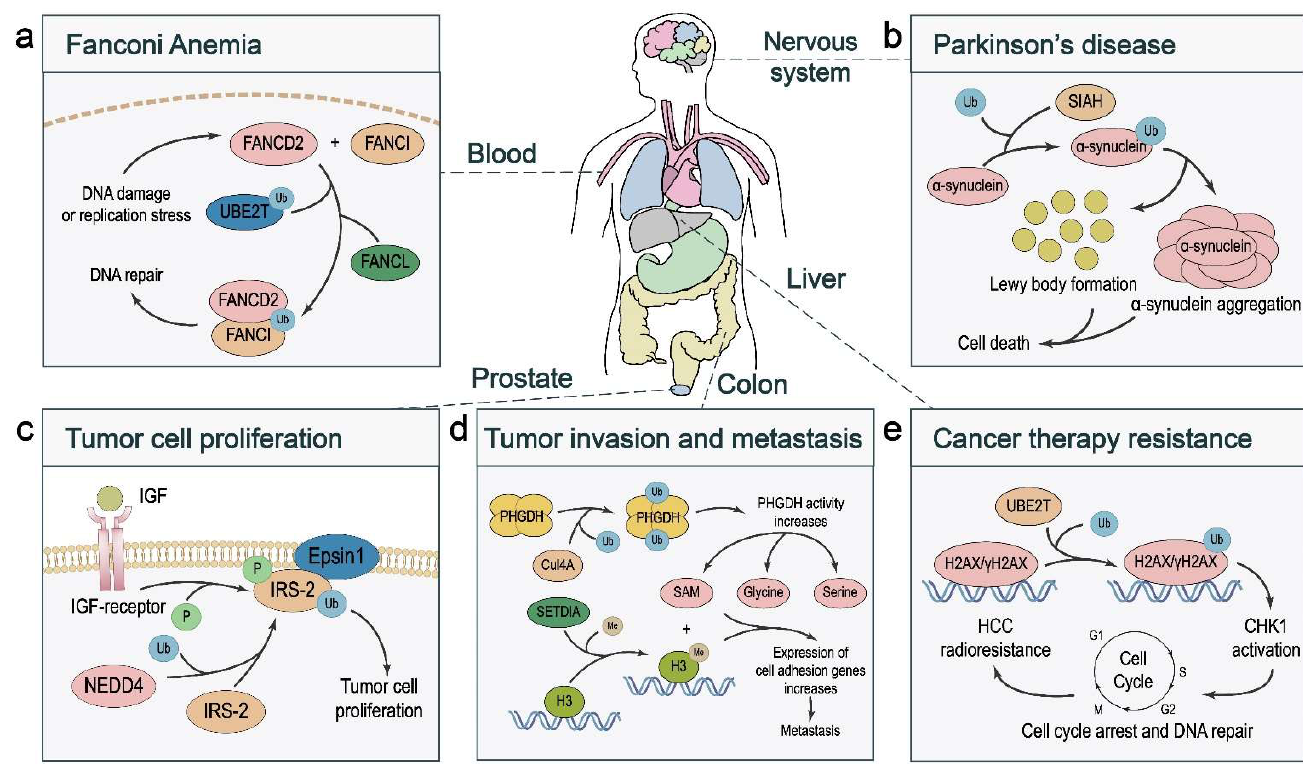
Figure 4. Diseases associated with dysregulated monoubiquitination. ( a ) In response to DNA damage or replication stress, the ubiquitin-conjugating enzyme UBE2T and the E3 ligase FANCL monoubiquitinate FANCD2 and FANCI, which facilitates the formation of the FANCD2–FANCI complex and DNA damage repair. In Fanconi anemia patients, impaired monoubiquitination of FANCD2 and FANCI results in DNA repair defects. ( b ) The E3 ligase SIAH monoubiquitinates α -synuclein, which promotes toxic α -synuclein aggregation, a hallmark of Parkinson’s disease. ( c ) In prostate cancer, NEDD4-induced monoubiquitination of IRS-2 enhances its association with Epsin1, which in turn promotes IGR receptor-mediated IRS-2 phosphorylation and cancer cell proliferation. ( d ) In colorectal cancer, the CUL4A-based E3 ligase complex monoubiquitinates and activates PHGDH, which increases the levels of serine, glycine, and S -adenosylmethionine (SAM). SAM promotes metastasis by upregulating cell adhesion gene expression via SETD1A-mediated histone methylation. ( e ) In liver cancer, UBE2T-mediated H2AX/ γ H2AX monoubiquitination activates CHK1 to promote DNA repair and radioresistance.